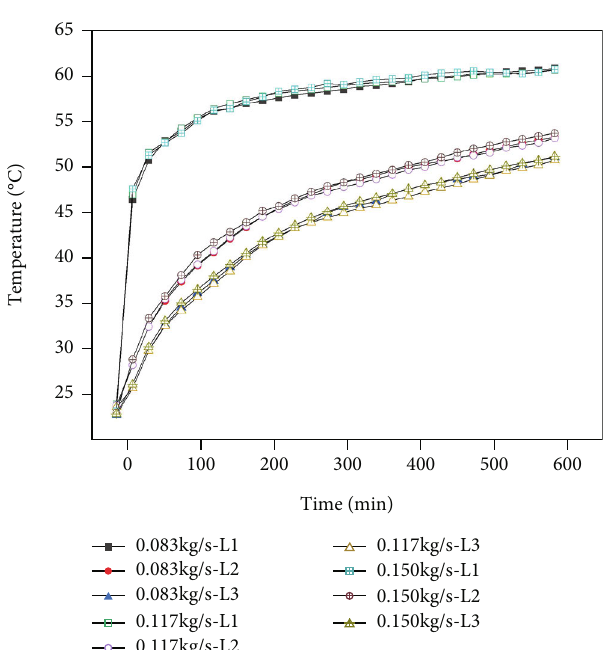
Figure 7: Temperature change of heat storage device under di ff erent heat fl ows and fl uid fl